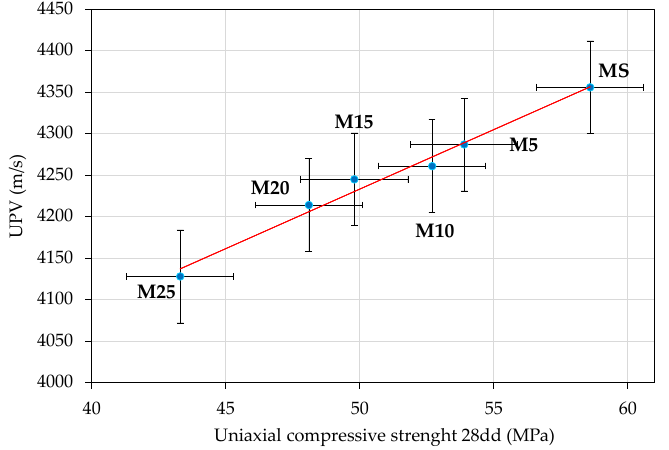
Figure 8. Compressive strength vs. ultrasonic pulse velocity (UPV) of the MS, M5, M10, M15, M20, and M25 mortar mixtures at 28 days of curing.